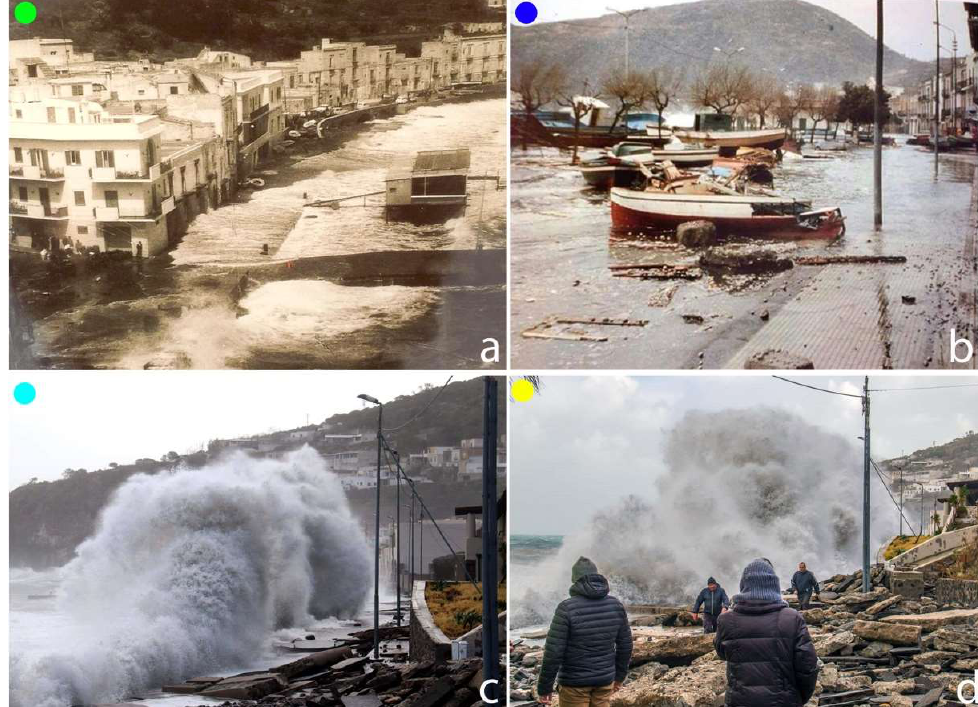
Figure 2. Coastal areas in the eastern and north-eastern Lipari sector particularly affected by flooding during storm surges: ( a ) Marina Lunga, ( b ) Canneto, ( c , d ) Acquacalda. Location of pictures is in Figure 1 through respective colored dots.